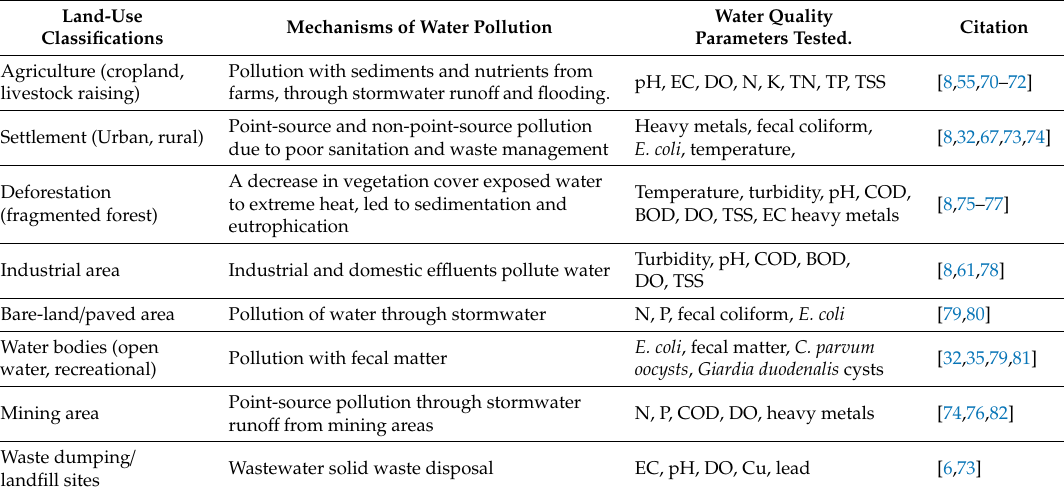
Table 2. Linking land use / land cover and surface water